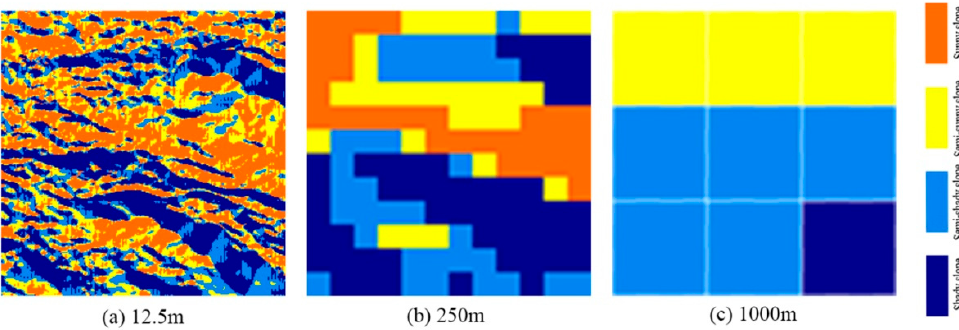
Figure 17. Aspect of Saihanba at different scales: ( a ) 12.5 m; ( b ) 250 m; ( c ) 1000 m.